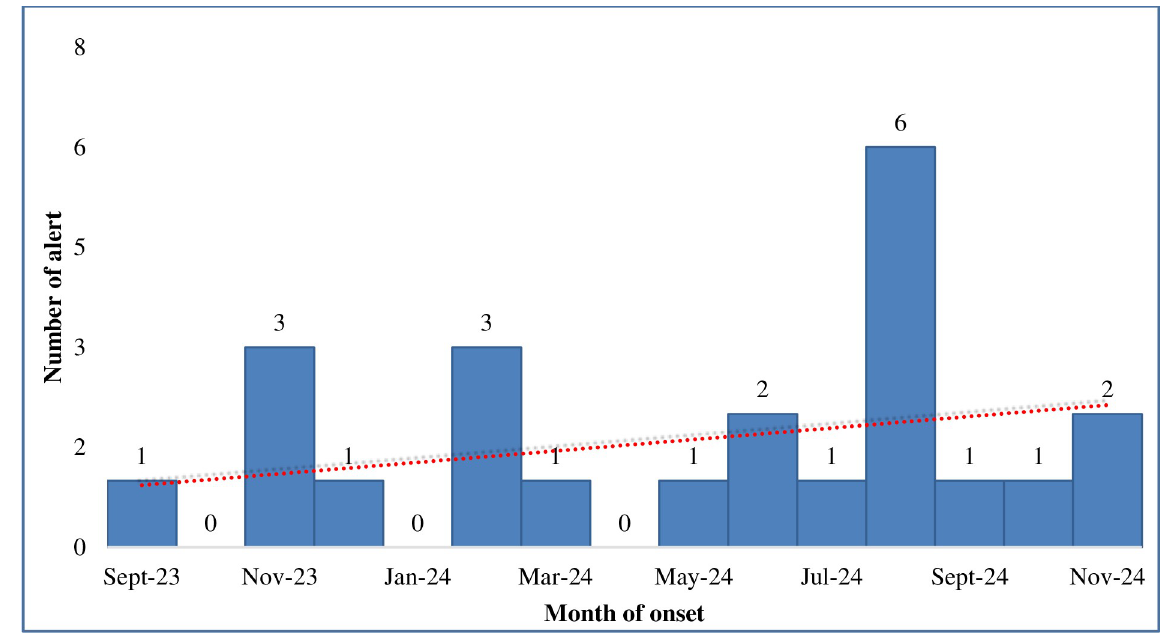
Fig 6. Distribution of EVD alerts by months in Gbudwe State, South Sudan—August 2018 to November 2019.